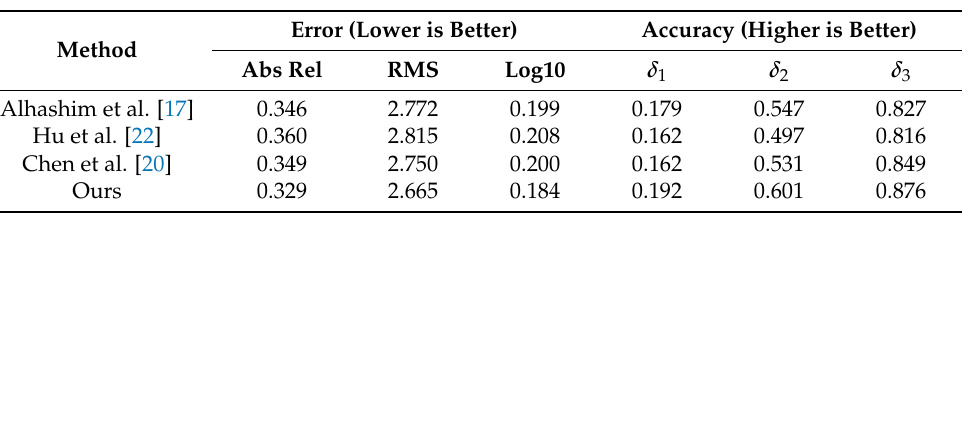
Table 7. Cross-dataset validation trained on NYU-Depth-V2 and tested on the iBims-1